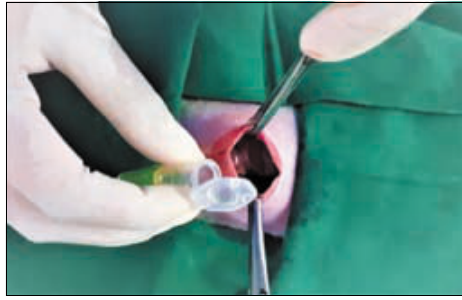
Fig. 3. Application of normal saline